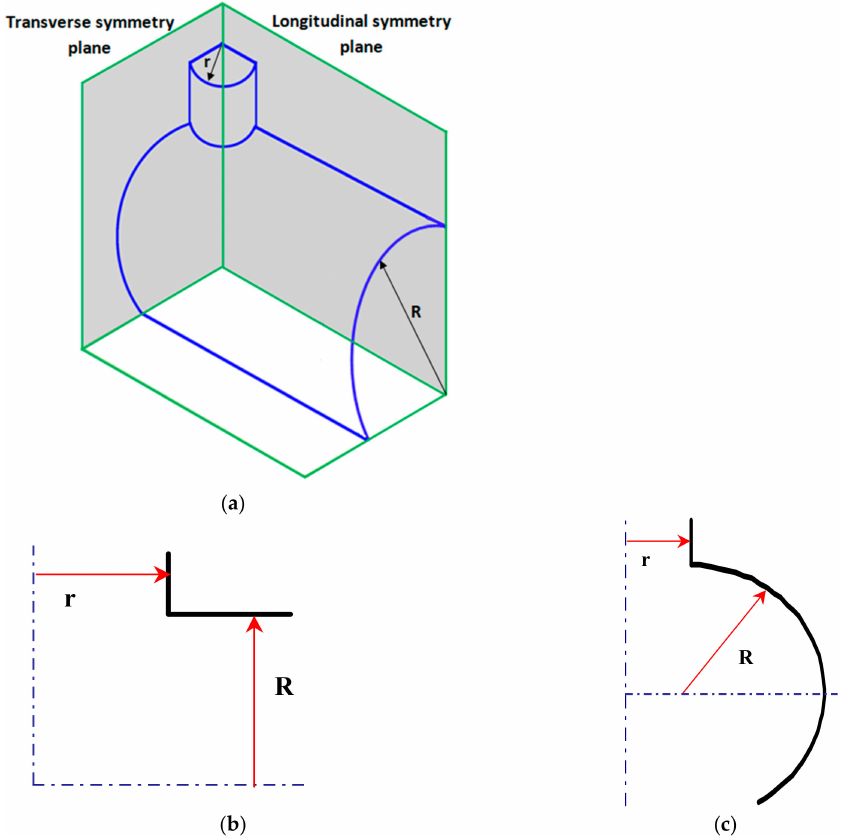
Figure 5. Cross-sections of the junction. ( a ) finite element model of the pressure vessel junction. ( b ) the longitudinal cross-section. ( c ) the transverse